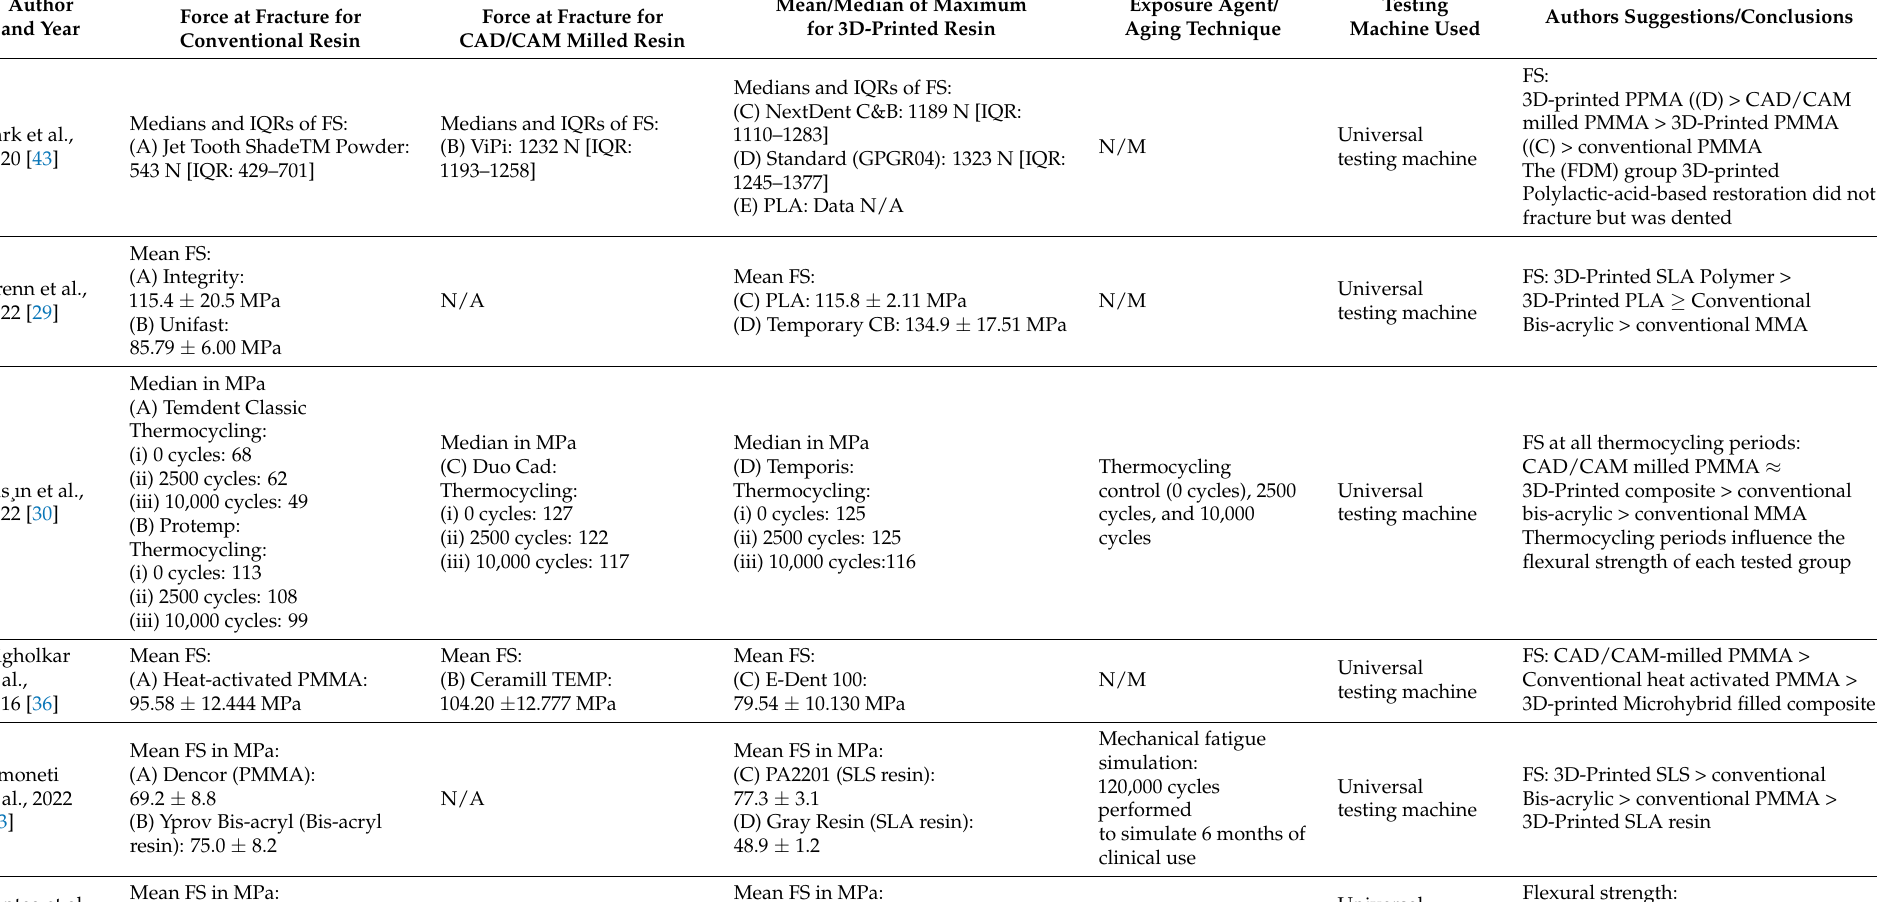
Table 11. Flexural strength (FS)